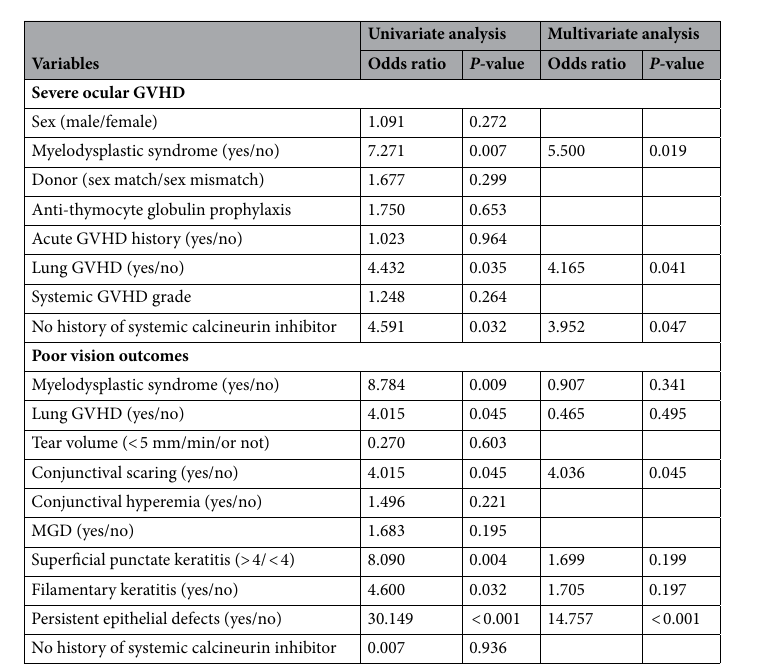
Table 5. Factors associated with severe ocular graft-versus-host disease (GVHD) and poor vision outcomes. CsA Cyclosporin, MGD Meibomian gland dysfunction.